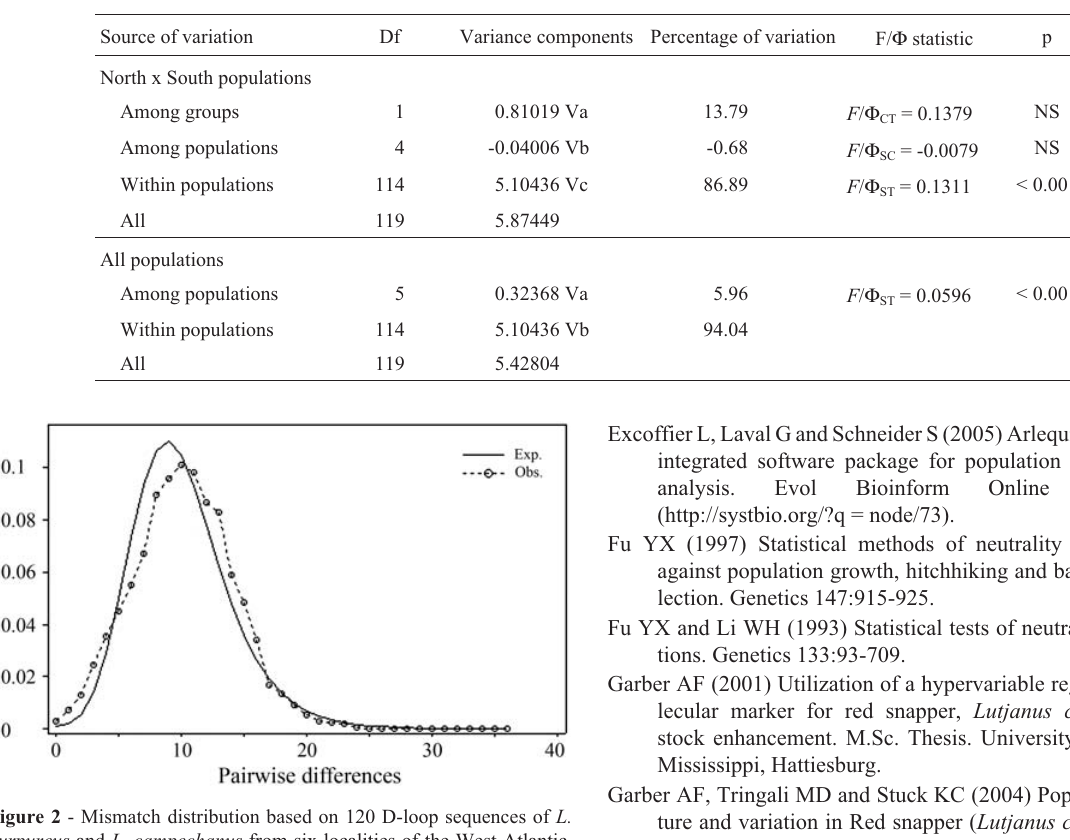
Table 2 - Analysis of Molecular Variance (AMOVA) for populations of L. campechanus and L. purpureus from six localities based on mitochondrial D-loop